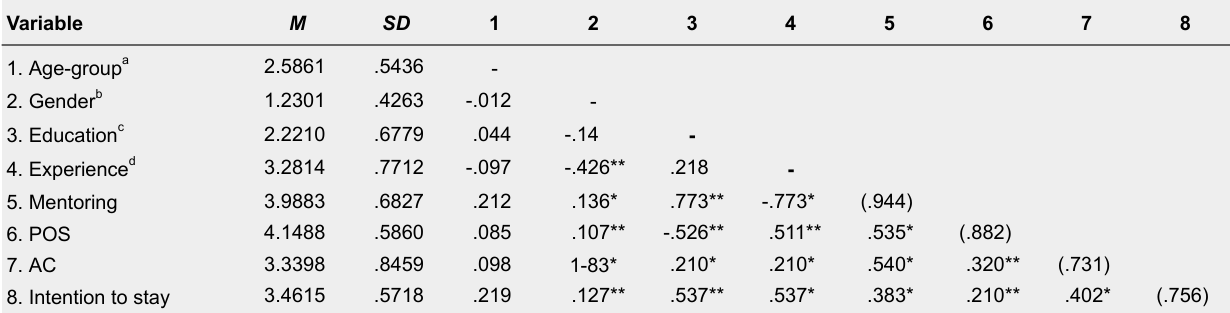
Descriptive Statistics and Correlations (N = 314)